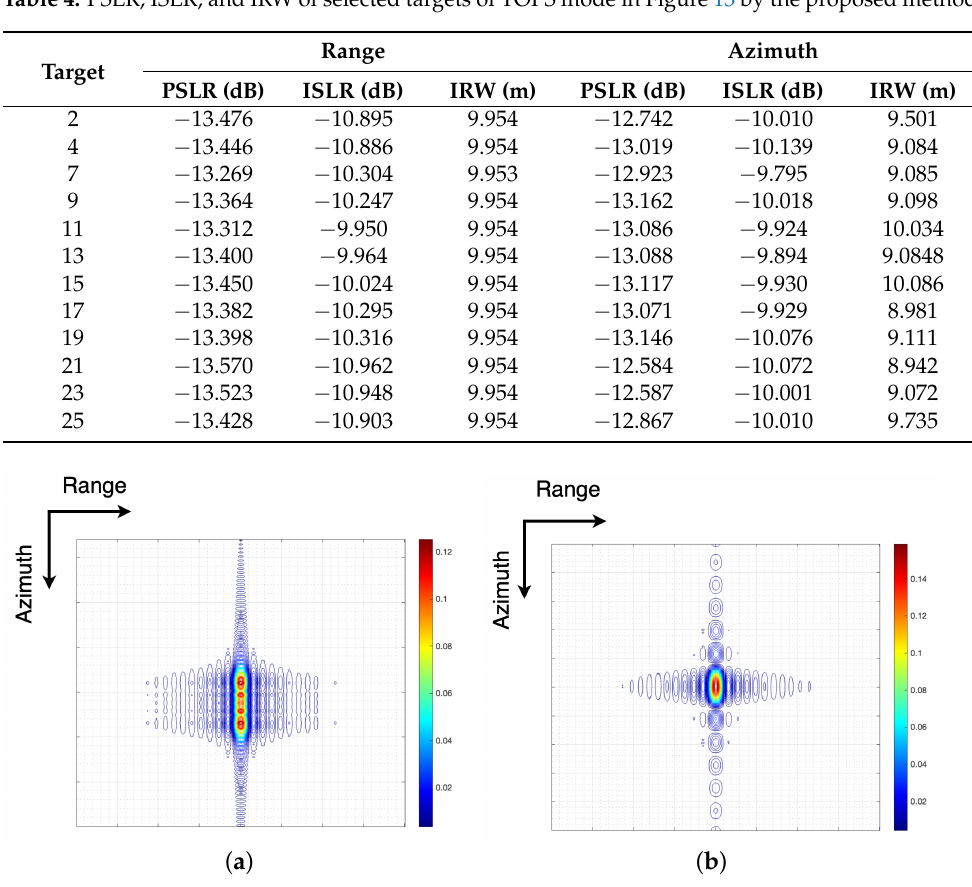
Figure 14. Comparison of imaging results obtained by convention NLCS method and the proposed method of TOPS mode. ( a ) The imaging result of NLCS method, considering the azimuth perturbation generated by local fit method. ( b ) The imaging result of our proposed